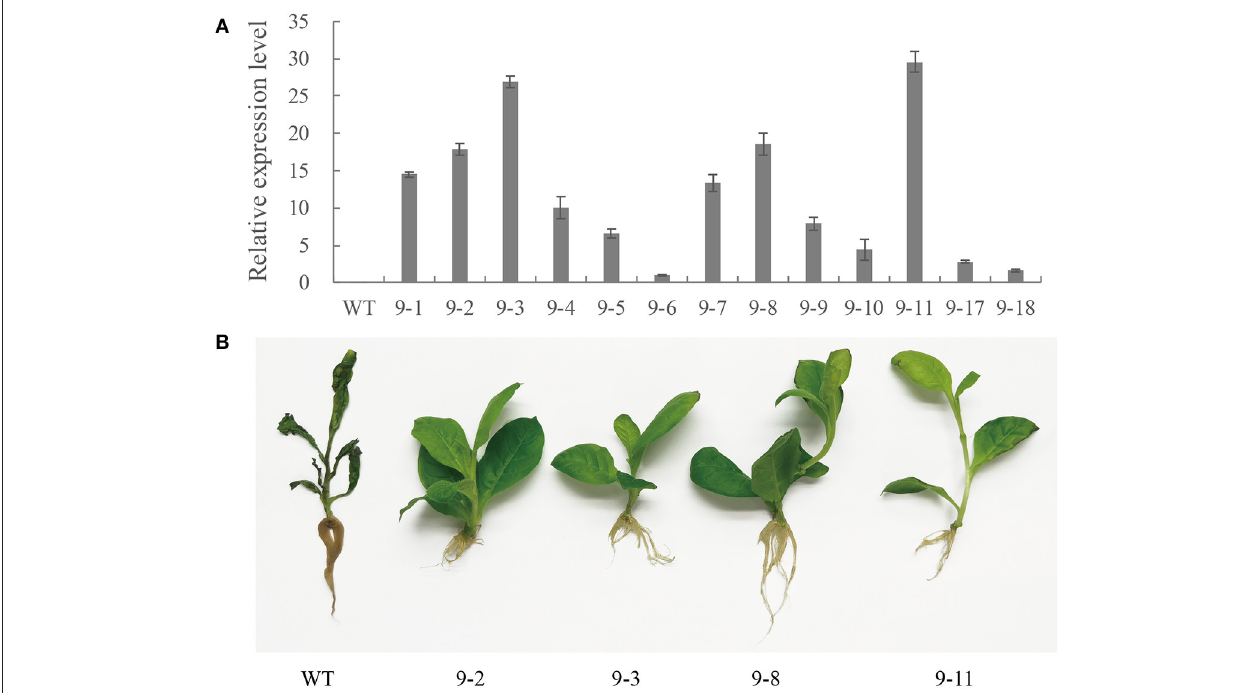
FIGURE 5 | Analysis of PnWRKY9 -OE tobacco. (A) PnWRKY9 expression levels in the overexpression tobacco. The PnWRKY9 was stably expressed in overexpression tobacco lines 9-1/2/3/4/5/6/7/8/9/10/11/17/18. (B) Resistance assay of PnWRKY9 -OE tobacco against F. solani . The PnWRKY9 -OE tobacco lines (9-2/3/8/11) and wild type (WT) tobacco roots were inoculated with F. solani . and the PnWRKY9 -OE tobacco showed higher level of resistance to F. solani than the WT.